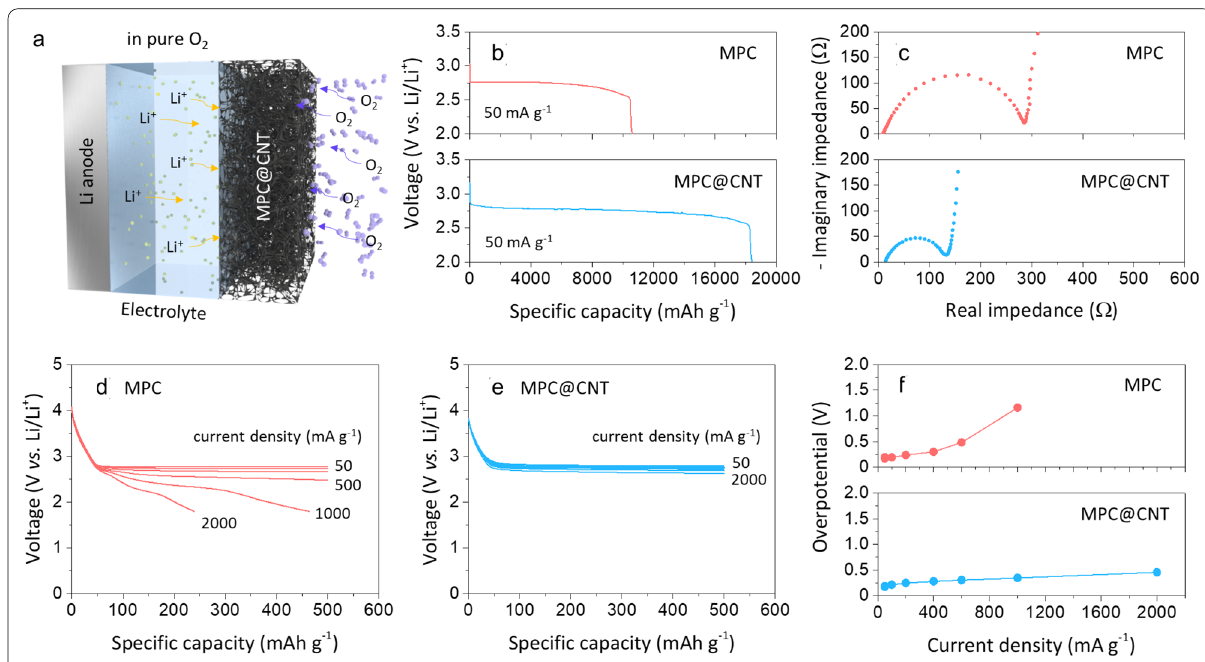
Fig. 3 a Schematic diagram for the LOB operating in pure O 2 . b Galvanostatic discharge profiles and c AC‑impedance spectra for the LOBs with fresh MPC and MPC@CNT. Discharge profiles of the LOBs with d MPC and e MPC@CNT measured at various current densities and f the plots of overpotential vs. current density obtained from the rate performance